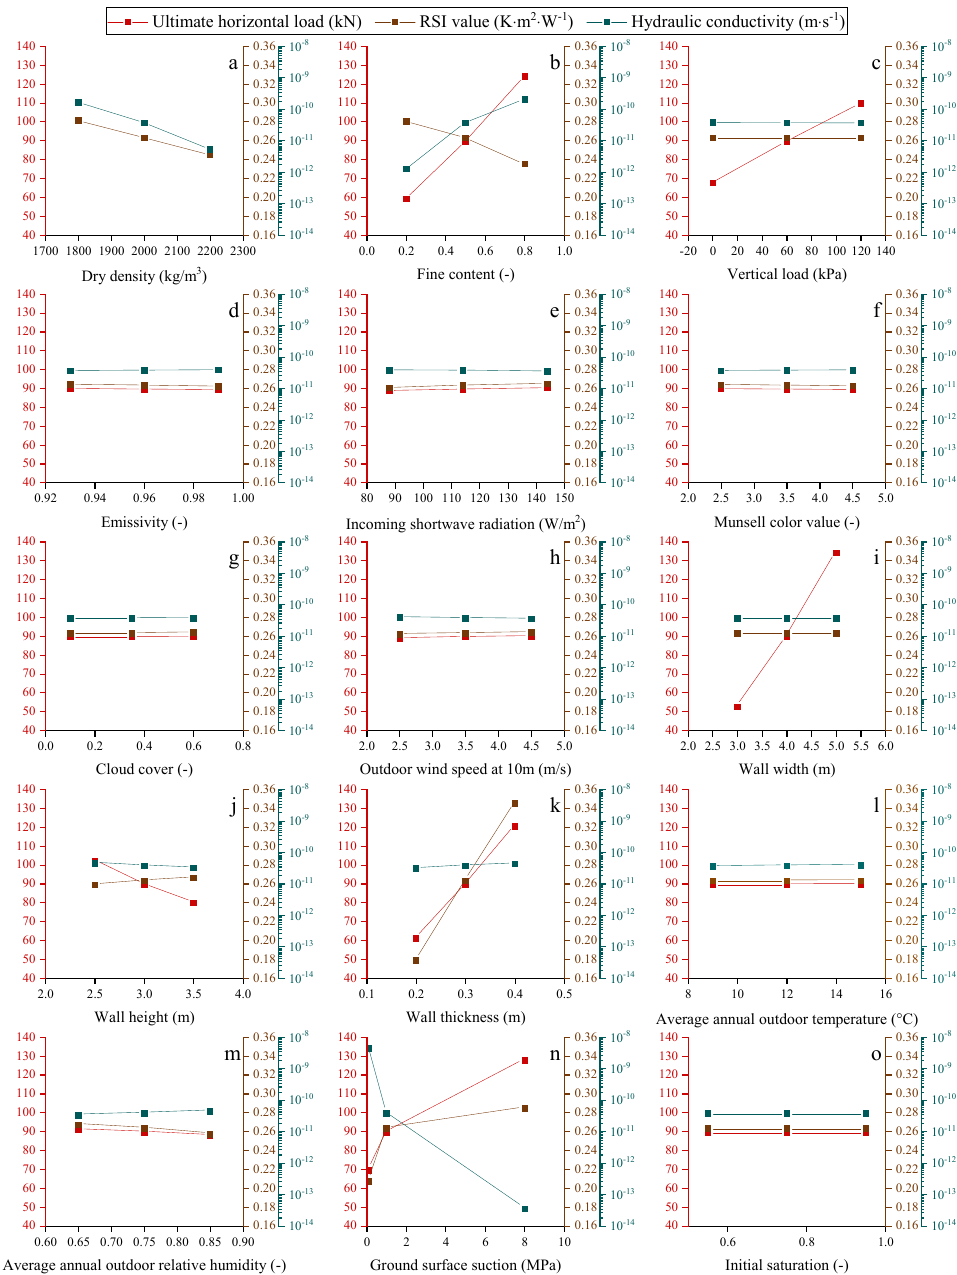
Figure 6. Variations of the average RSI value, hydraulic conductivity, and pushover strength with the influences of different factors for the walls built after five years.